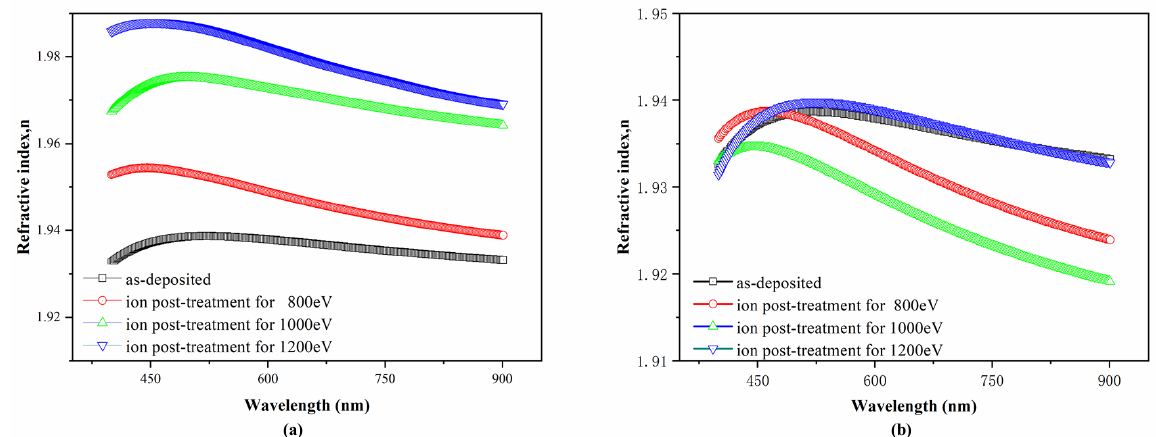
Figure 5. Refractive index of HfO 2 film irradiated at various ion energies under Ar ( a ) and O 2 ( b ) atmosphere.